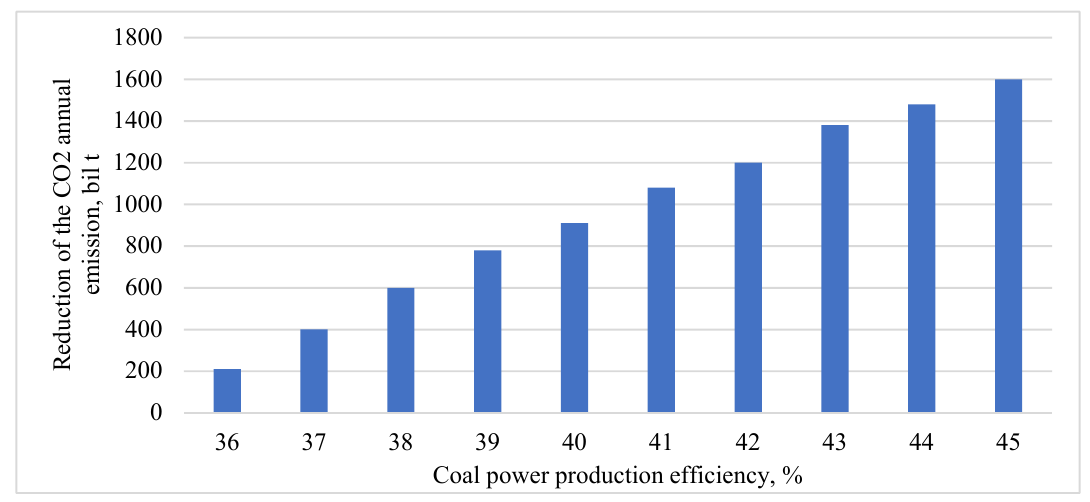
Figure 4. Relation of CO 2 emission reductions and coal-firing TPP efficiency.